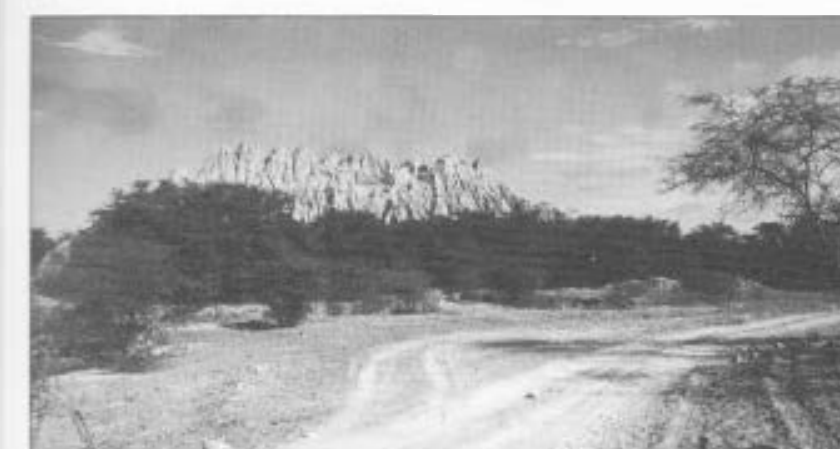
Figure 1 The eroded mud brick temple platform ofHuaca Loro, part of the Middle Sic6.n capital (c. AD 900-1100}, northern Peru.